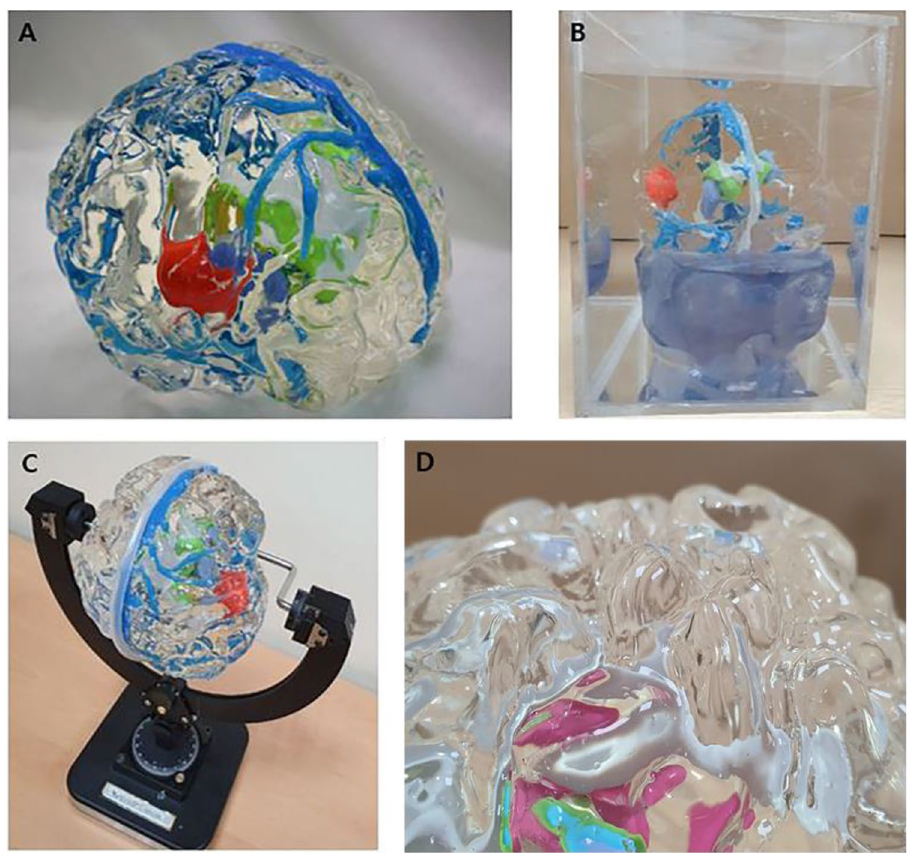
Figure 2. ( A ) The final 3D-printed brain model of right insular glioma. Normal brain parenchyma with expression of the gyri and sulci was reconstructed using transparent silicon material. The tumor is colored light red, the ventricle system is light gray, the caudate nucleus is yellow-green, the thalamus is light blue, and the major venous system is blue. The soft real brain-like texture of the model enables the neurosurgeon to simulate surgery by incising and excavating the area of interest. ( B ) The internal structure of the model can be clearly observed, and diffuse reflections can be eliminated by placing the model in the water tank. ( C ) The surgical approach can be fine-tuned with a dedicated fixator that can determine the rotation angle of the model in all directions. ( D ) The closure view of the model shows the details of gyri and